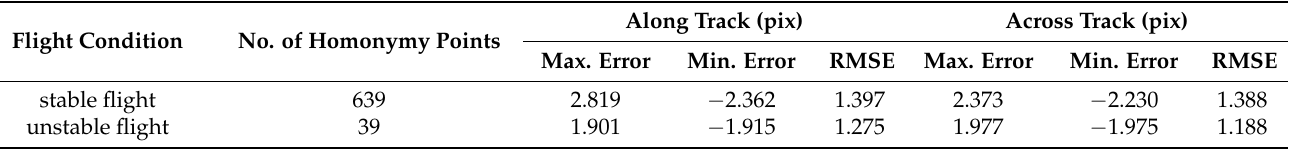
Table 18. Relative orientation residual of EA-unstable-5 (left-middle